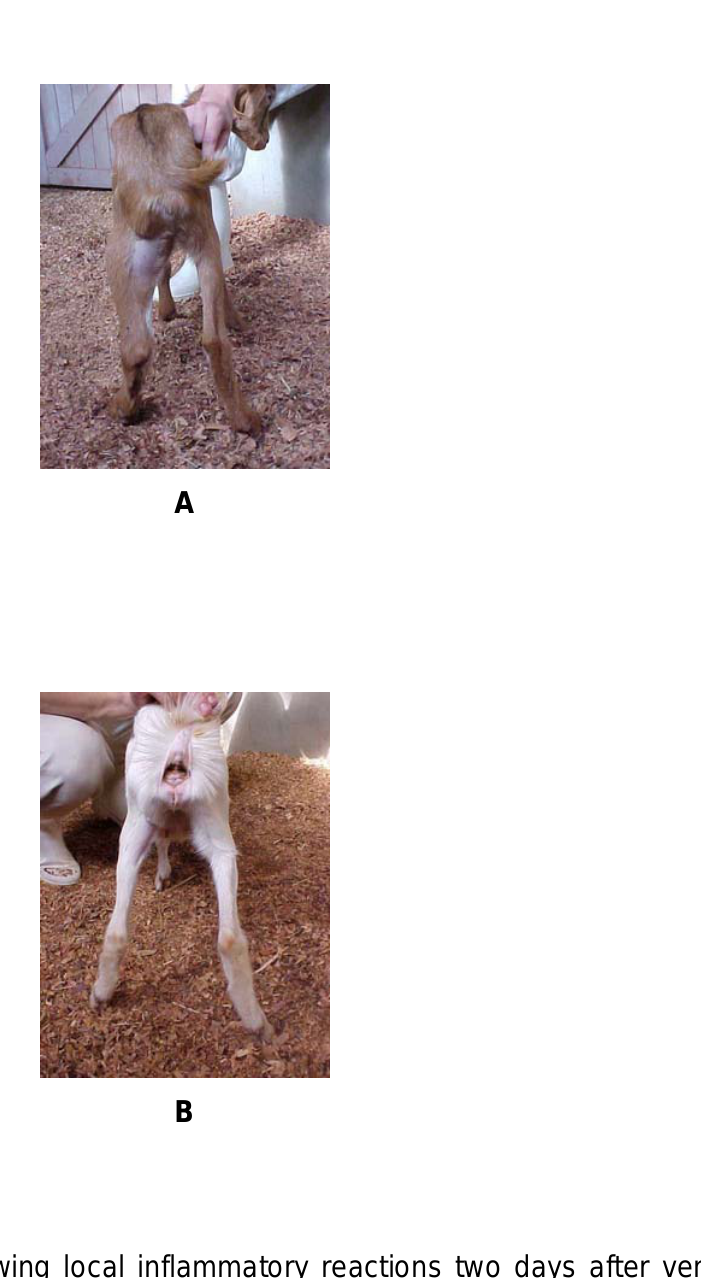
Figure 2. Photographs showing local inflammatory reactions two days after venom injection. A: one animal of the group inoculated with natural venom (GINV), B: one animal of the group inoculated with irradiated venom